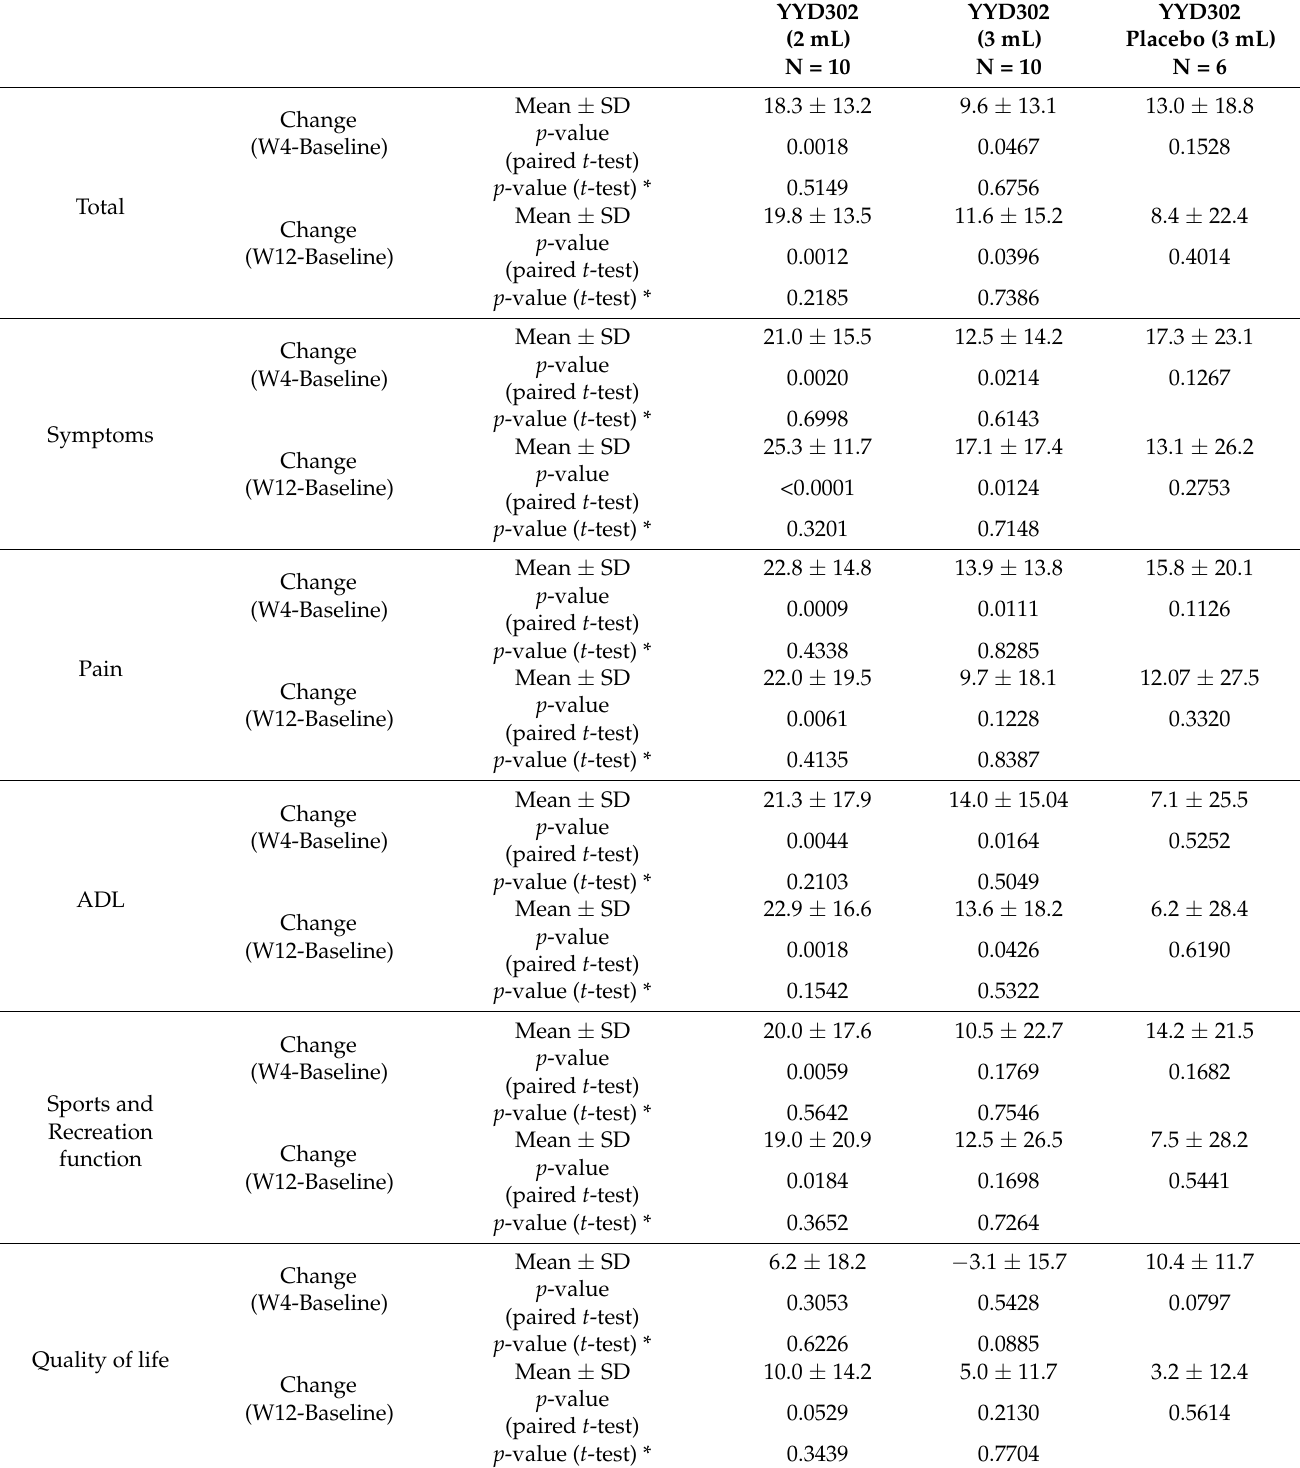
Table 3. Changes in the KOOS values at 4 weeks (visit 4) and 12 weeks (visit 5) after administration, compared to baseline